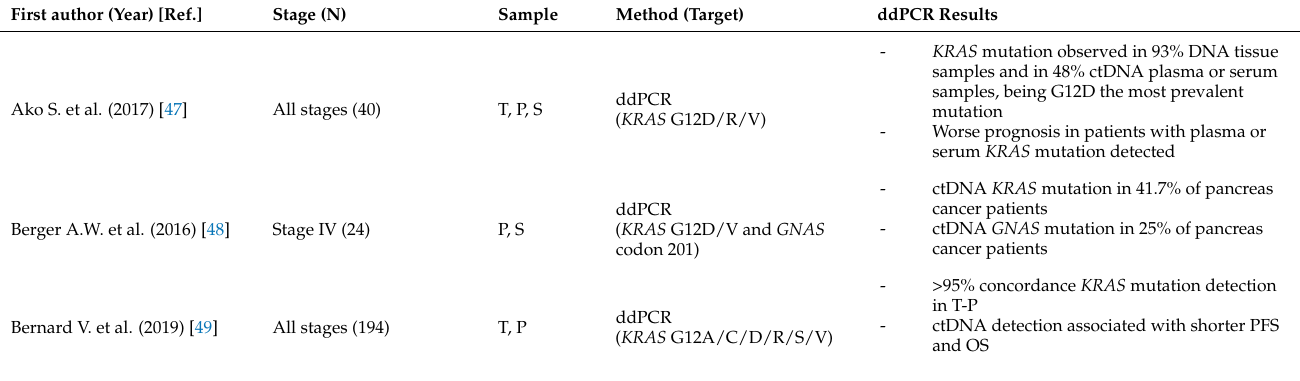
Table 1. Most relevant studies of digital-droplet PCR (ddPCR) ctDNA application in pancreatic cancer. First author (Year)